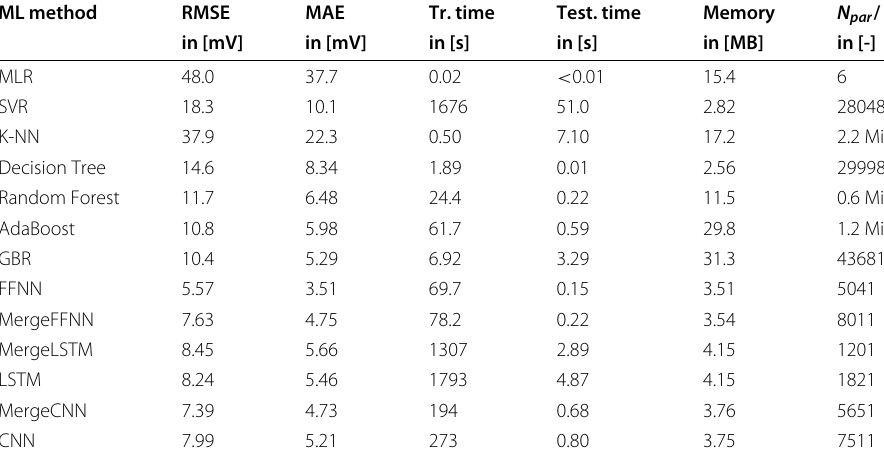
Table 2 Comparison of the performance of the different ML methods